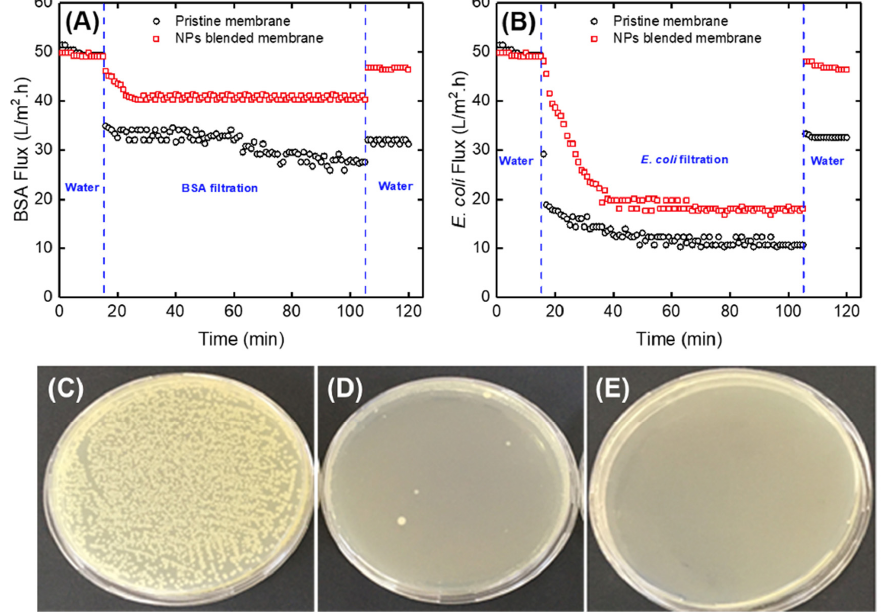
Figure 8. Application of polyethersulphone (PES) membrane blended with γ -Fe 2 O 3 -CA-Leu-Gly-PDX for ( A ) BSA flux versus time, ( B ) E. coli flux versus time, ( C ) inlet E. coli culture (control), ( D ) permeate of PES membrane and ( E ) permeate of modified PES membrane.